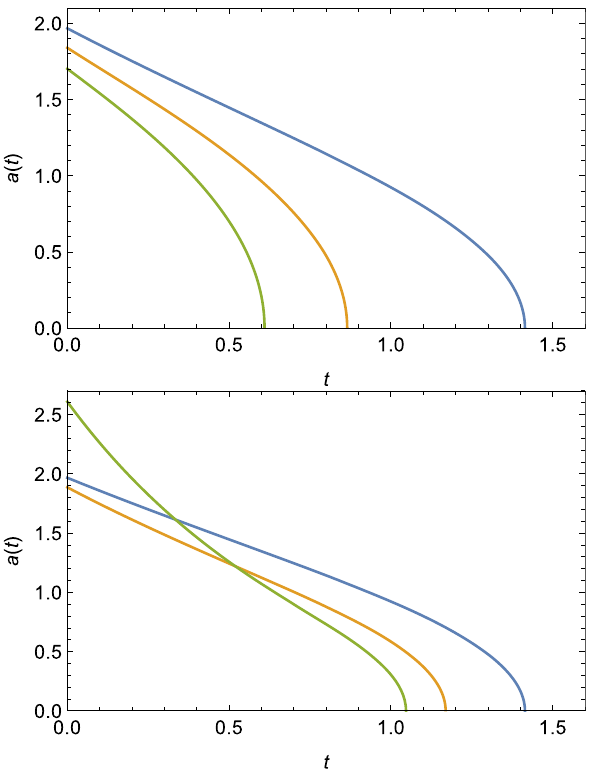
Fig. 1 Evolution of the two-sphere for a collapsing scalar field. The Fig. 2 Evolutionofthetwo-sphereforacollapsingandbouncingscalar critical condition for this is a 0 is positive. For the graph on top, the field. The critical condition for this is a 0 is negative. For the graph on choice of a 0 is varied (the blue curve is for a 0 = 1, The Yellow Curve top, the choice of a 0 is varied (the blue curve is for a 0 = − 1, the is for a 0 = 3 and the green curve is for a 0 = 5.) while m = 1 √ yellow curve is for a 0 = − 2 and the green curve is for a 0 = − 3.) while . For the 2 m = 1 √ . For the graph on bottom, the choice of a 0 is fixed at a 0 = − 1, graph on bottom, the choice of a 0 is fixed at a 0 = 1, while value of m 2 is varied (the blue curve is for m = 1 √ , the yellow curve is for m = 1 while value of m is varied (the blue curve is for m = 1 √ 2 and the green curve is for m = 2) curve is for m = 1 and the green curve is for m =